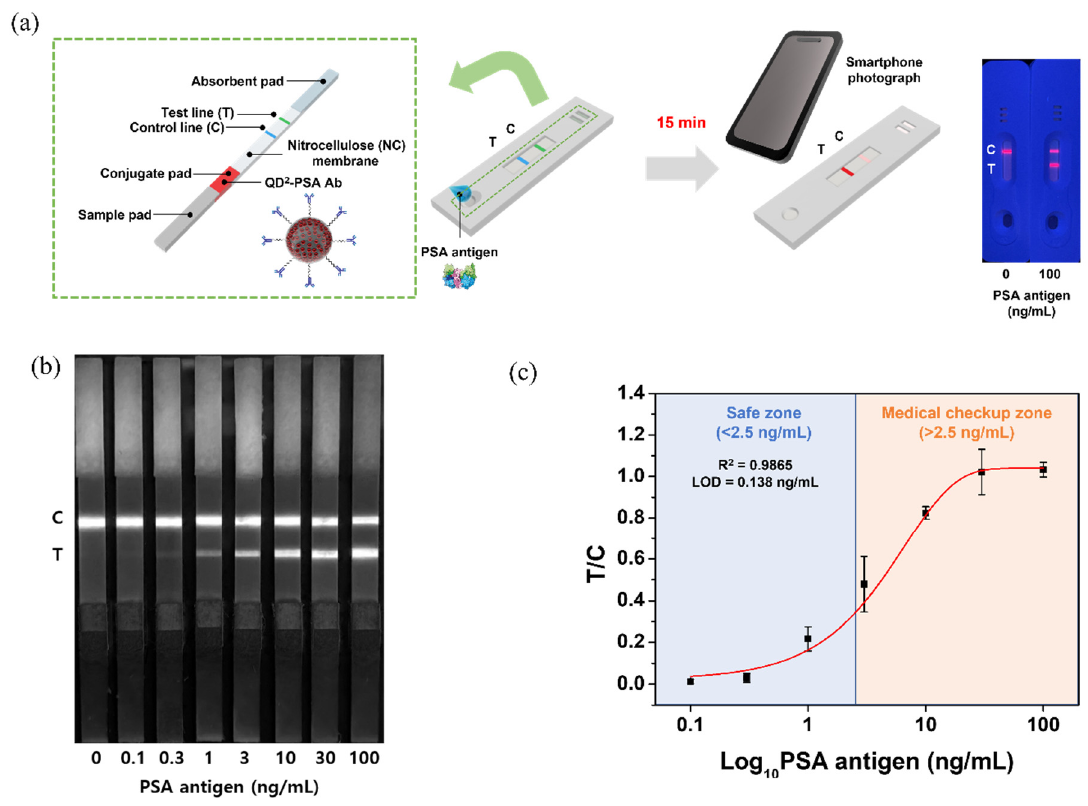
Figure 2. ( a ) Schematic illustration of lateral flow immunoassay (LFIA) process and precise analysis; ( b ) fluorescence image showing only the red channel of the test strip with PSA developed under a 365 nm UV lamp; ( c ) T/C value and fitting curve of the fluorescence intensity generated for each concentration of PSA. Table 1. PSA concentration in clinical